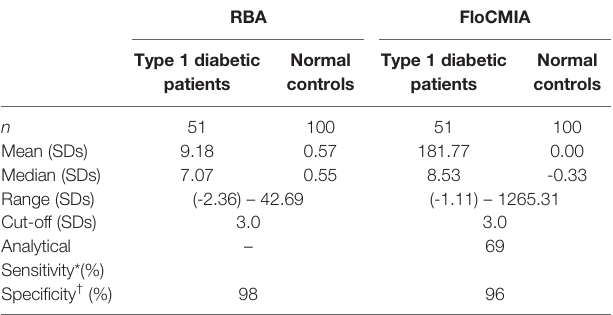
TABLE 2 | Analytical parameters of RBA and FloCMIA from normal human controls and type 1 diabetic patients. RBA FloCMIA Type 1 diabetic Normal Type 1 diabetic Normal patients controls patients controls